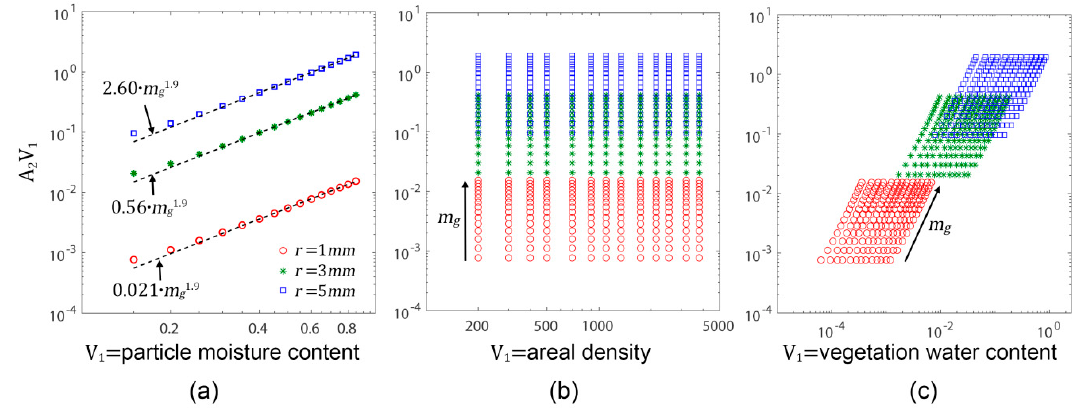
Figure 1. Variations of A 2 V 1 in the case of spherical particles as a function of ( a ) the particle moisture content ( m g [g / g]), ( b ) the areal density ( N a [m − 2 ]), and ( c ) the vegetation water content (VWC [kg / m 2 ]). Note that both the vertical and horizontal axes are scaled logarithmically.